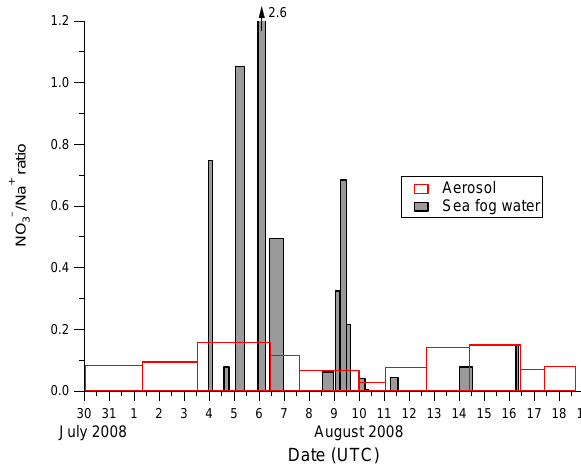
Figure 7. The mole equivalent ratios of NO 3– /Na + in aerosols (red open bars) and sea fog 2 Fig. 7. The mole equivalent ratios of NO − water (gray bars) during the cruise. The widths of red open and gray bars indicate the 3 open bars) and sea fog water (gray bars) during the cruise. The sampling duration of aerosol and sea fog water samples, respectively. 4 widths of red open and gray bars indicate the sampling duration of aerosol and sea fog water samples,